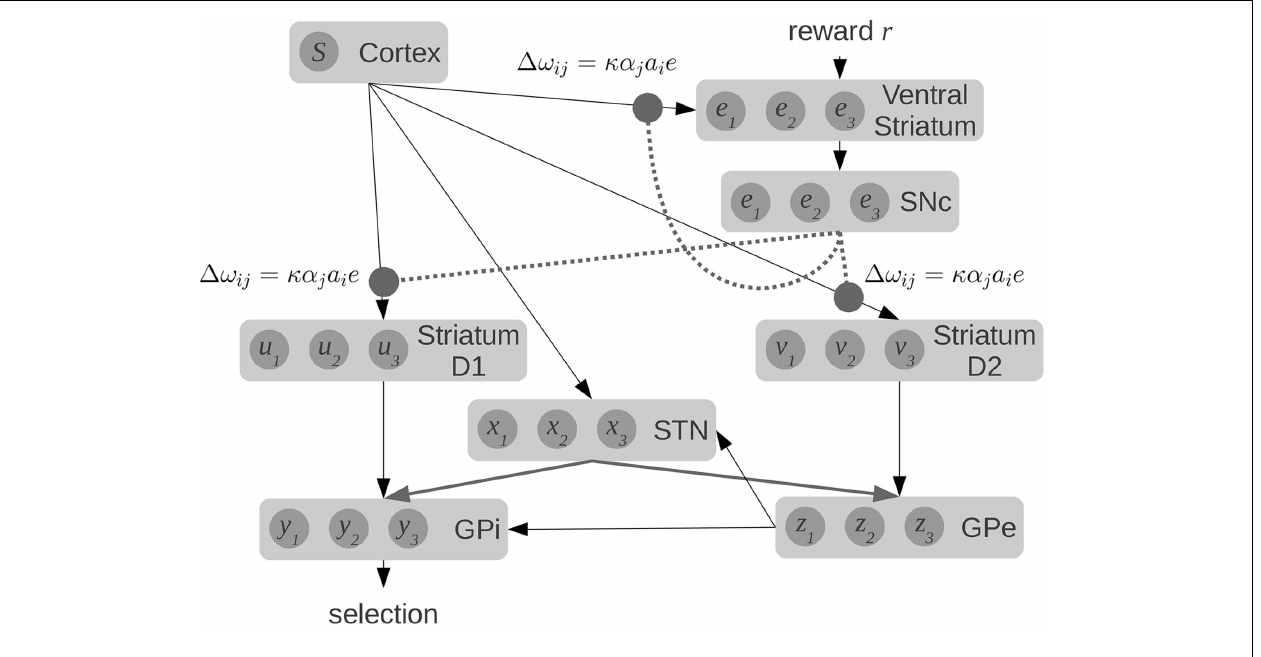
FIGURE 6 | Our spiking model of reward-based learning and action selection in the cortex and basal ganglia. Dotted lines show dopaminergic connections from the substantia nigra pars compacta (SNc) which modulate the local synaptic strengths using the equations